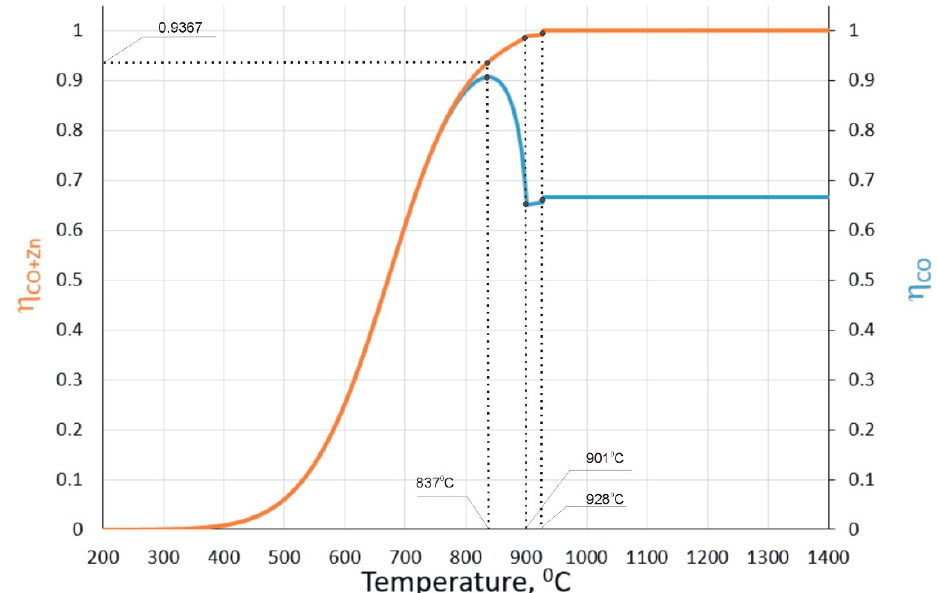
Figure 5. Gas-phase-reducing ability dependent upon the temperature for ZnO-CO-C. From the route of the blue equilibrium curve, the ranges of character reduction pro- cesses of ZnO can be seen. So, at 837 °C there is a maximum value of quotient η (cid:2887)(cid:2899) due to increased Zn and CO 2 in the gas phase; thus, indirect reduction according to reaction (II) is started and lasts until 901 °C. In range 901–928 °C, Zn is still increased, but CO 2 drops; thus, the types of reduction—indirect and direct—take place there. Over 928 °C, CO 2 is completely absent in the gas phase because of its consumption by the Boudouard reaction (III). There is only direct reduction can take place according to the mechanism (II) + (III) = (IV). The read value of quotient η (cid:2887)(cid:2899)(cid:2878)(cid:2910)(cid:2924) = 0.9367 at the temperature 837 °C shown in Fig- ure 5 means an equilibrium of the gas phase at the start of ZnO indirect reduction. It is necessary for building the fuel consumption minimization model. 2.3. Fuel Rate Minimization Model Construction The principles of the optimal division of direct and indirect reduction in ironmaking blast furnaces (IBFs) are based on the theory of A.N. Ramm, who first noticed the depend- ence of coke consumption on the share of wustite direct and indirect reduction. A support algorithm for fuel consumption optimization was successfully implemented in blast fur- nace practice [28,29]. The shared principles of optimal direct reduction rate (d DR ) and in- direct reduction rate (d IR ) adopted to ISP technology are shown in Figure 6. Figure 6. Carbon rate–ZnO reduction ratio diagram.